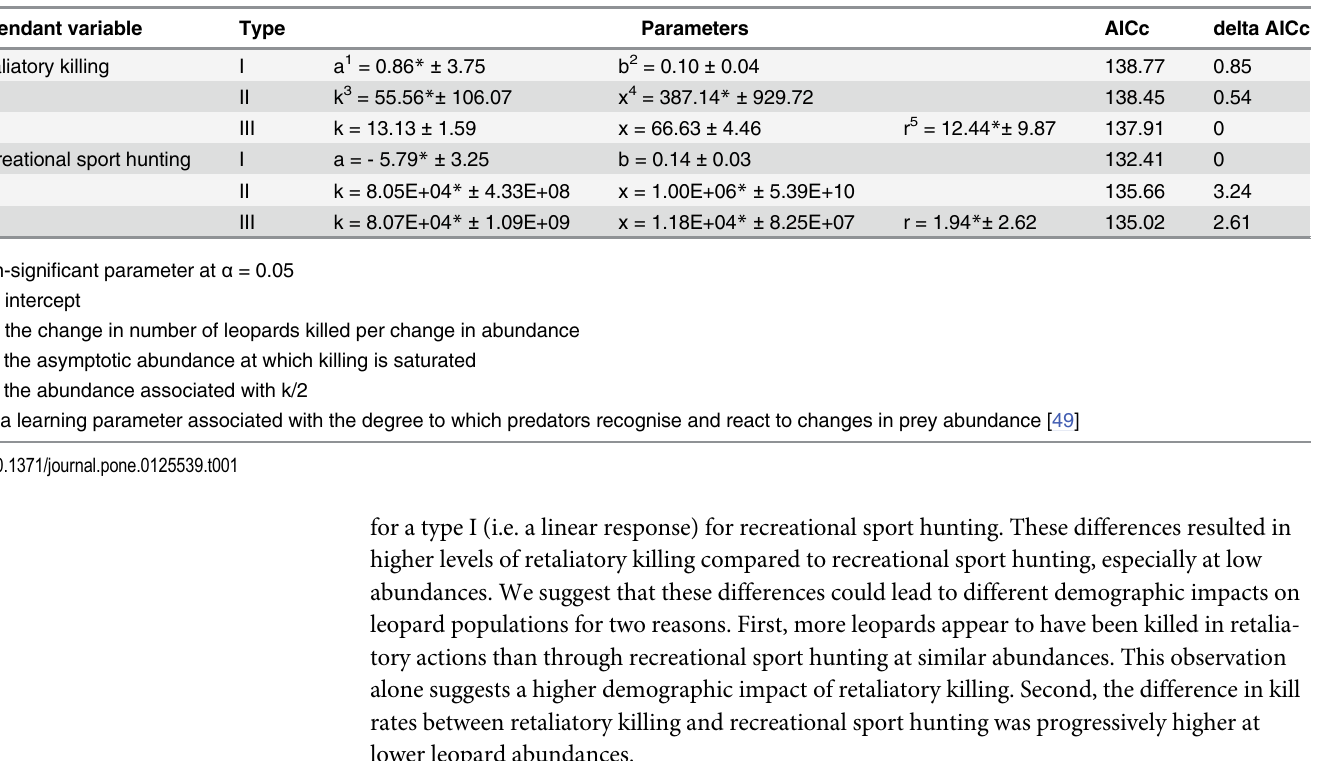
Table 1. Akaike information criteria corrected for small sample sizes (AICc), delta AICc (representing the difference in AICc between the current and the most appropriate model) and parameter estimates associated with type I, type II and type III functional response models for leopards killed in retaliatory incidents and leopards hunted and in the Waterberg District Municipality, Limpopo Province, South Africa.